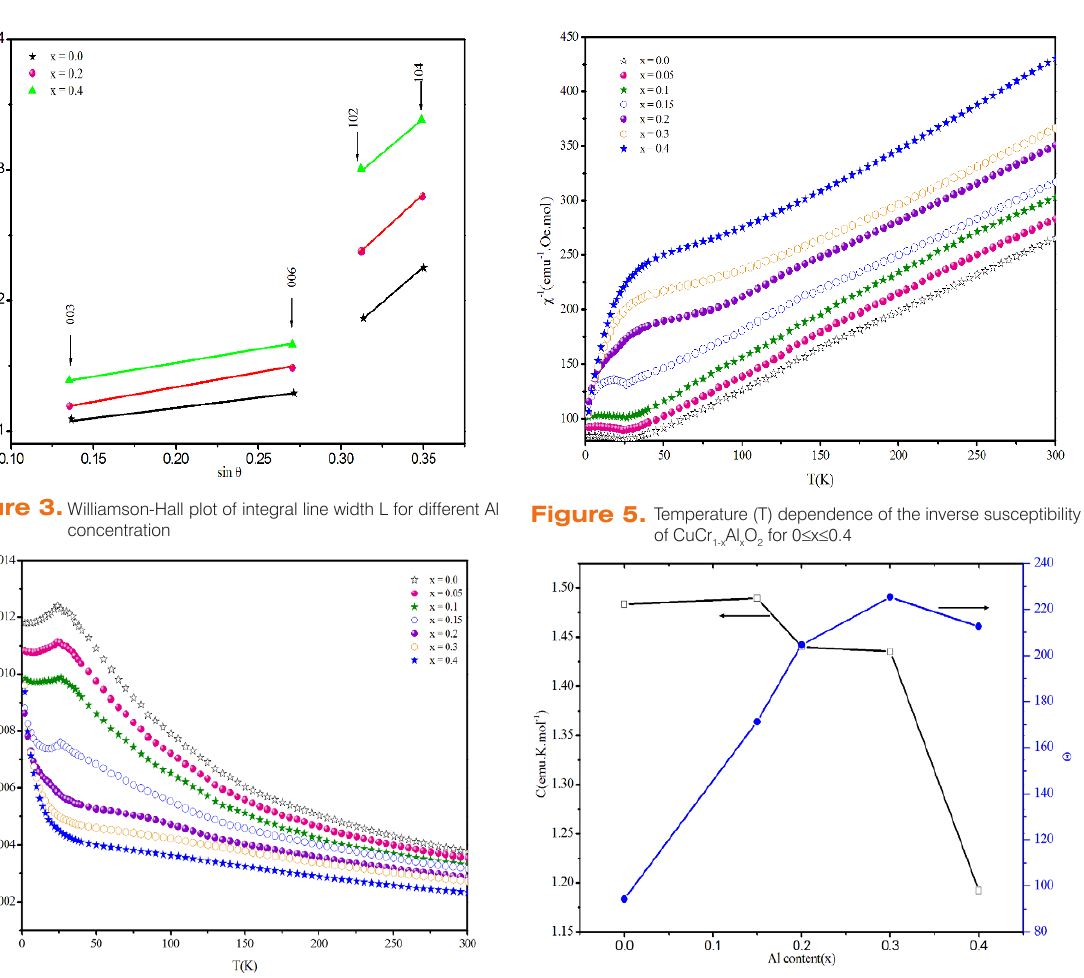
Figure 4. Temperature (T) dependence of zero-field- cooling susceptibility of CuCr